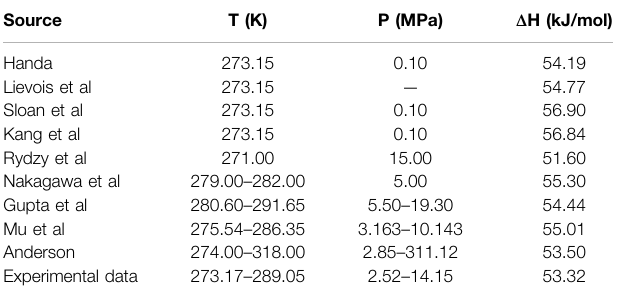
TABLE 3 | Reported values of decomposition enthalpy of methane hydrate (Handa, 1986; Lievois et al., 1990; Sloan and Fleyfel, 1992; Kang et al., 2001; Anderson, 2004; Rydzy et al., 2007; Gupta et al., 2008; Nakagawa et al., 2008; Mu and von Solms,